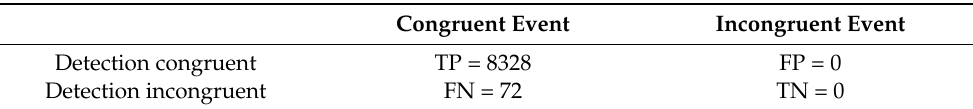
Table 9. Contingency table that assists with the detection of congruences in the Landsat 8 scene of the Doce River basin acquired in 2017 and consisting of 8400 tiles (TP—true positive, FP—false positive, FN—false negative, TN—true negative).